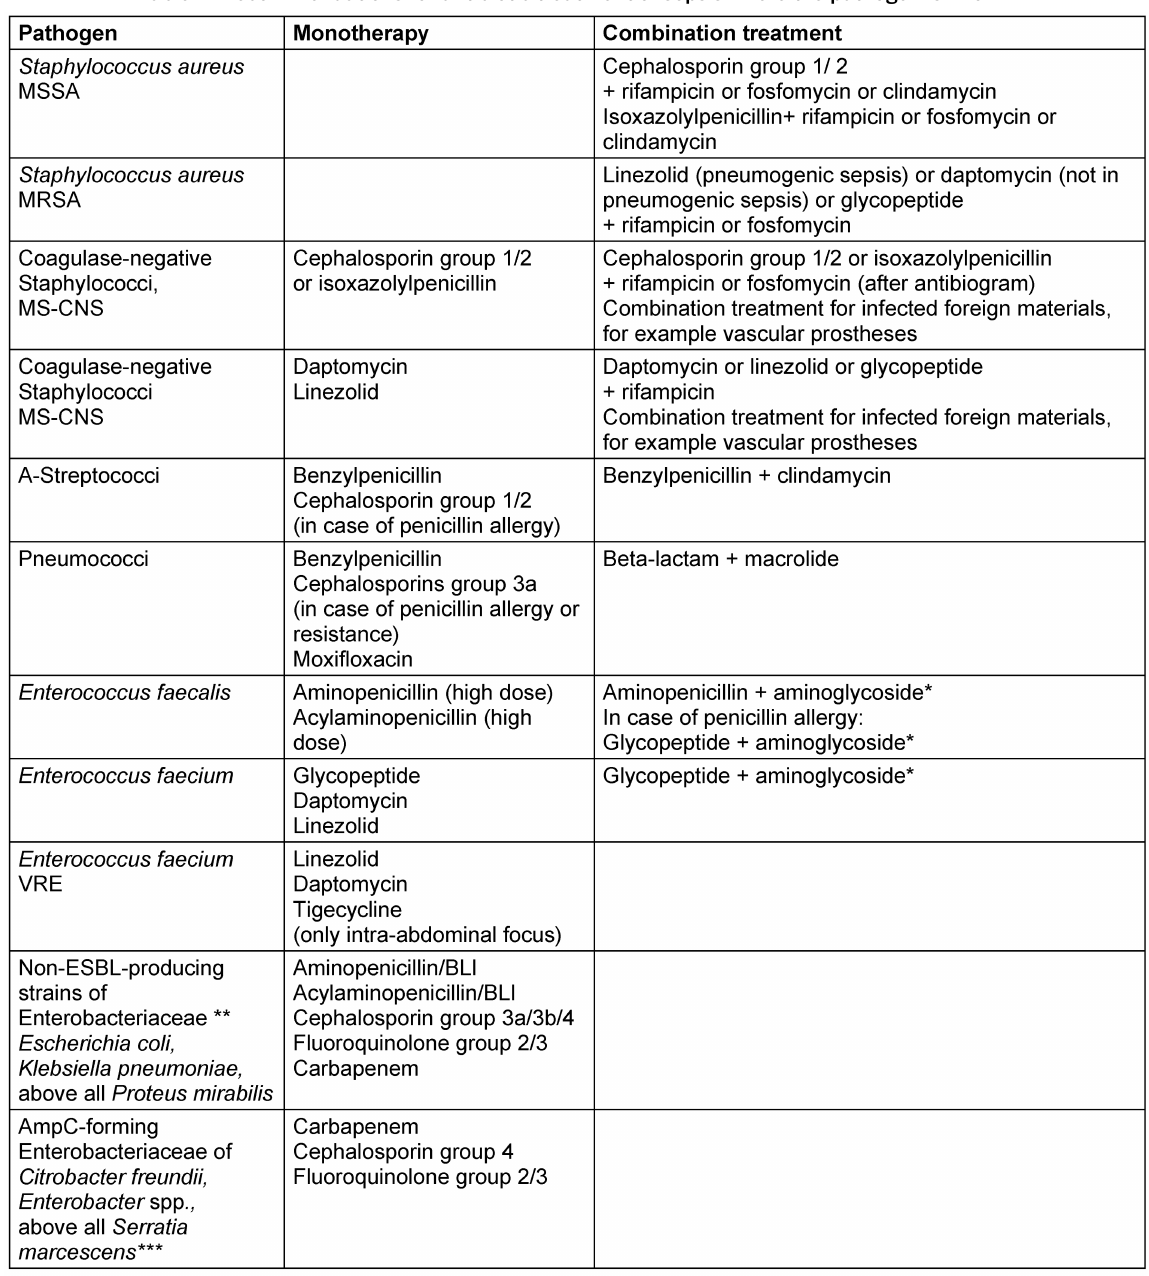
Table 2: Recommendations for antibiotic treatment of sepsis where the pathogen is